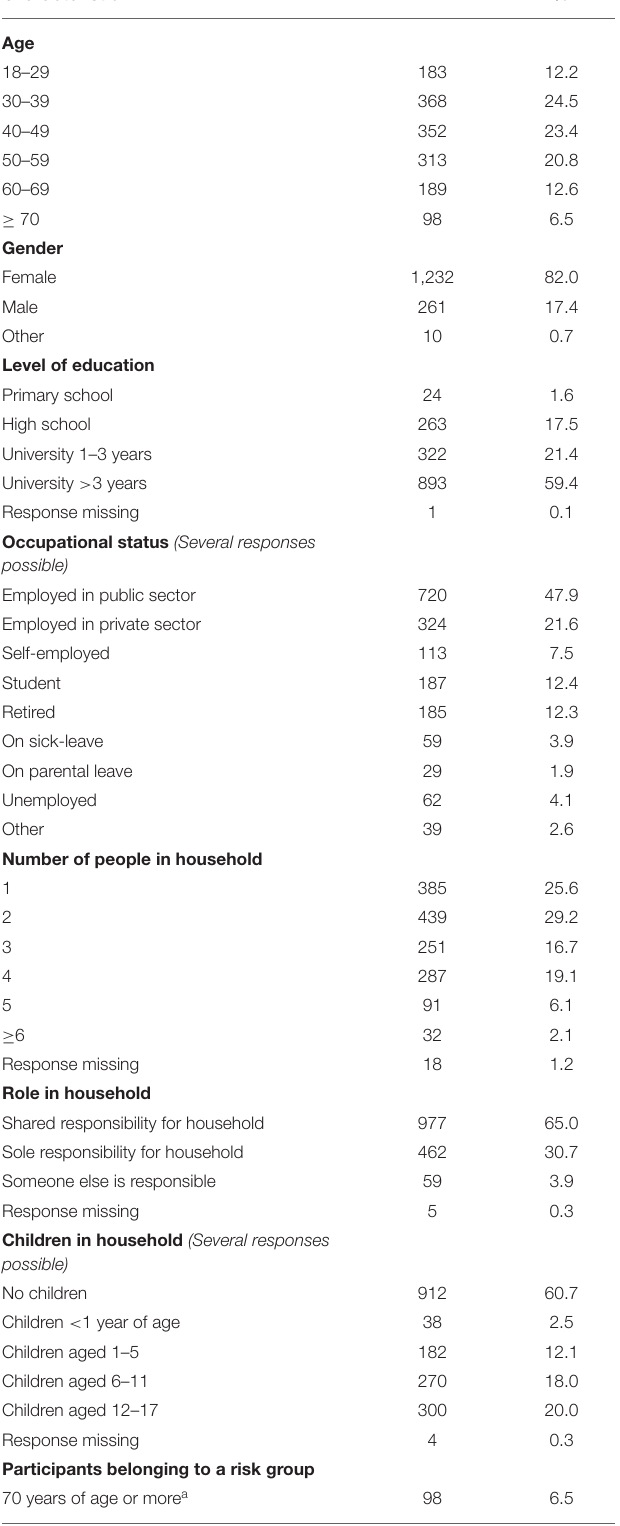
Depressive Symptoms The multiple linear regression for depressive symptoms